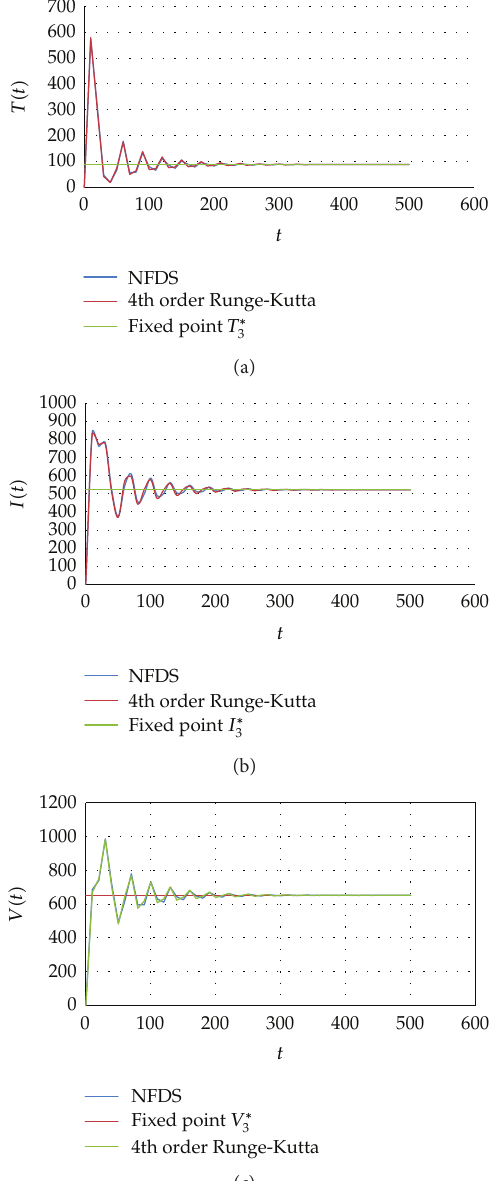
2 is unstable and HIV infection persist in T-cell